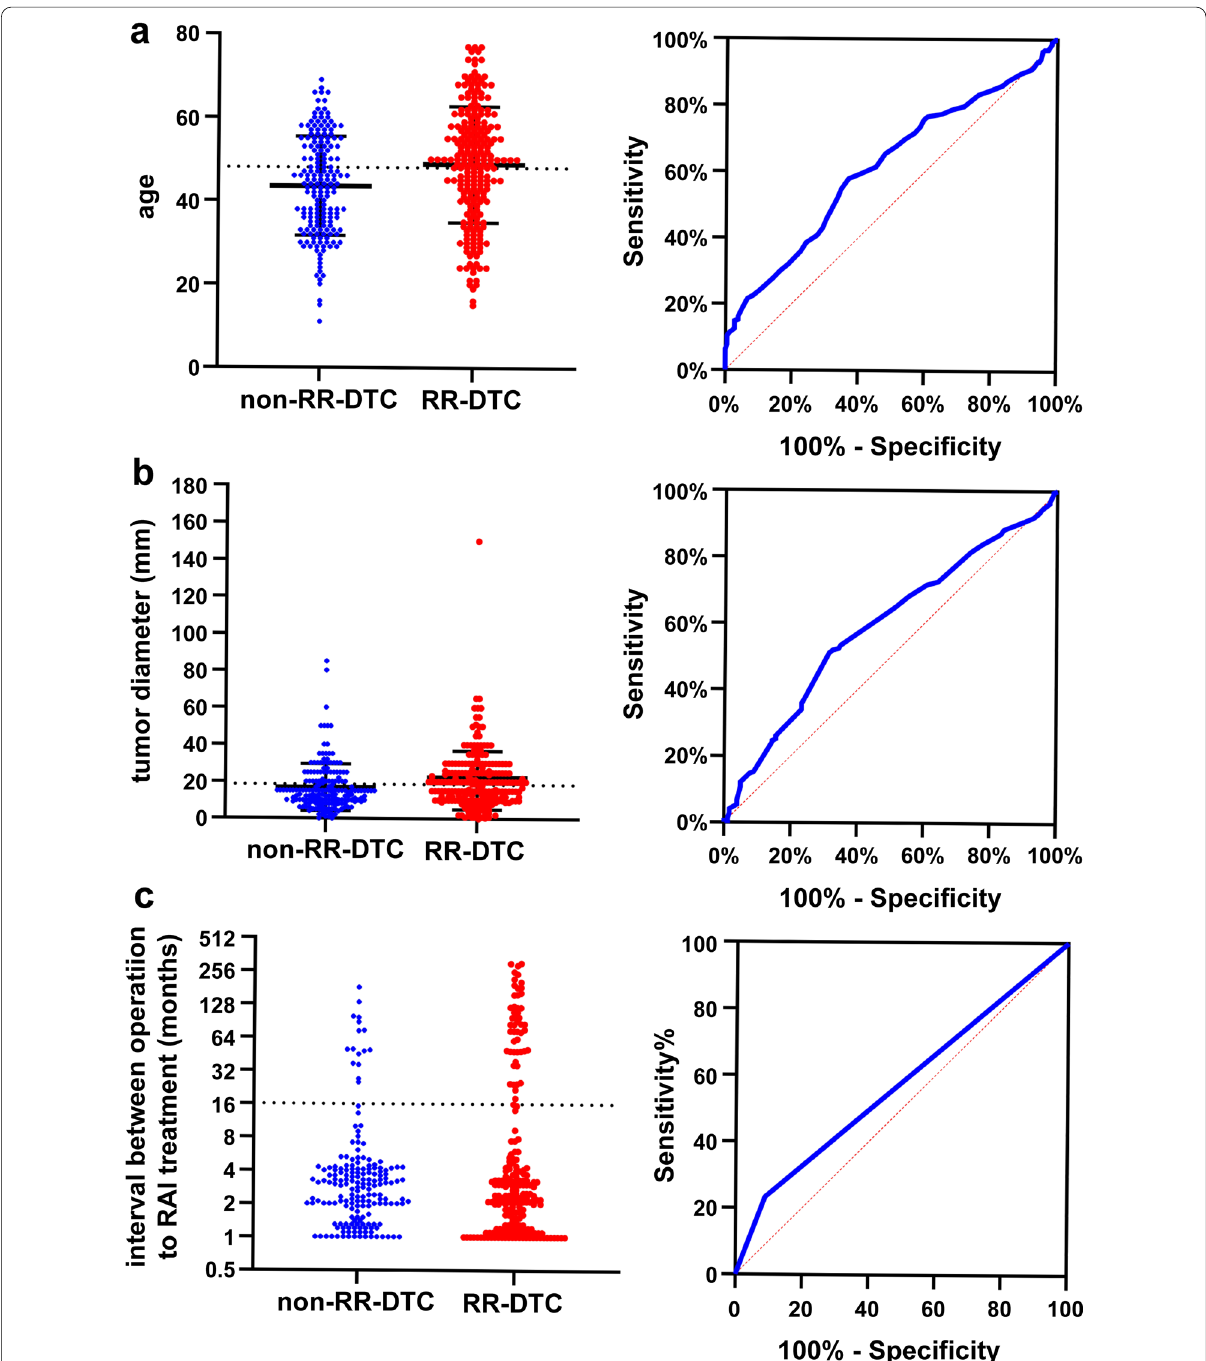
Fig. 3 ROC curve to predict RR-DTC. a The optimal age at diagnosis was 48 years, and the AUC was 0.613. The sensitivity and specificity were 58% and 63%, respectively. b The optimal primary tumor diameter was 18.5 mm, and the AUC was 0.591. The sensitivity and specificity were 51% and 68%, respectively. c The optimal time from the first operation to the first iodine-131 treatment was 16 months, and the AUC was 0.572. The sensitivity and specificity were 23% and 91%, respectively. ROC, receiver operating characteristic; RR-DTC, radioiodine refractory differentiated thyroid carcinoma; AUC, area under the